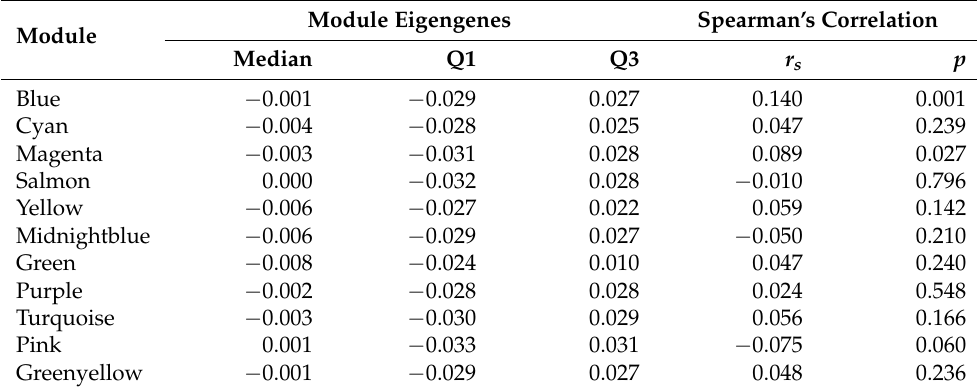
Table 4. Distribution of module eigengenes and their association with MoCA score 1